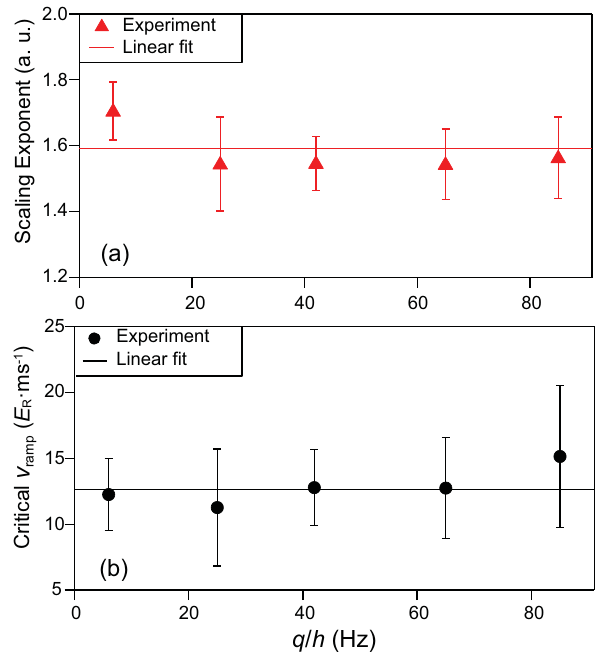
Fig. 4 Quantum critical dynamics in different magnetic fi elds. a The scaling exponent extracted from the power-law fi ts as illustrated in Fig. 2c at various quadratic Zeeman energy q . b The critical lattice quench speed v fi ts shown in Fig. 2c as ramp at the intersection of the linear and power-law a function of q . Solid lines are linear fi ts. Here h is the Planck constant, the unit of v ramp is E R per millisecond ( E R ⋅ ms − 1 ), and E R is the recoil energy. Symbols correspond to values extracted from fi ttings over at least eight datasets taken at each q and error bars represent one standard